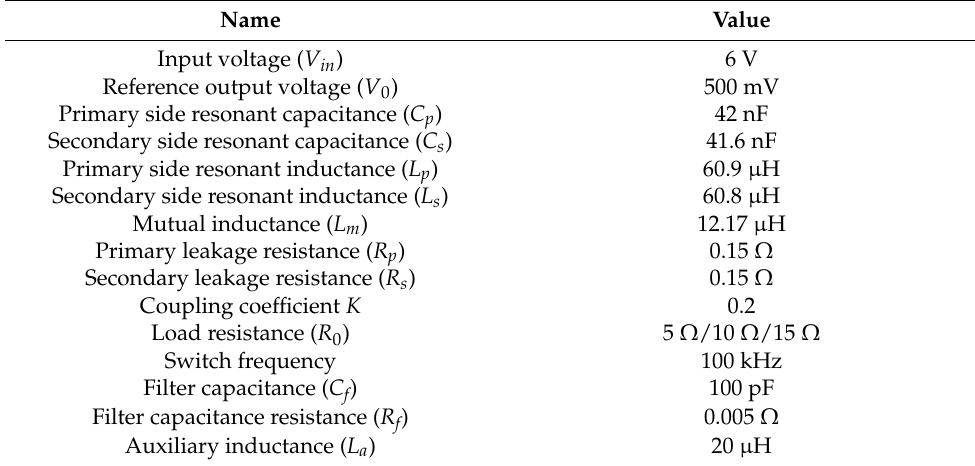
Table 5. Ratings in experimental circuit.